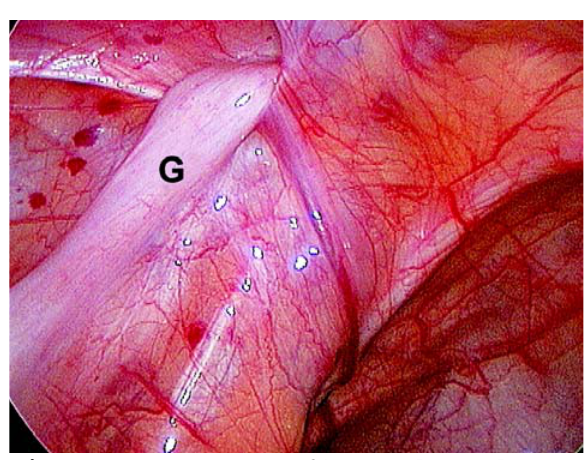
Figure 1 – Laparoscopic view of the internal inguinal ring. We observe the testicular gubernaculum and vessels crossing the in- guinal ring; the deferent duct is not identified. G = gubernacu- lum.